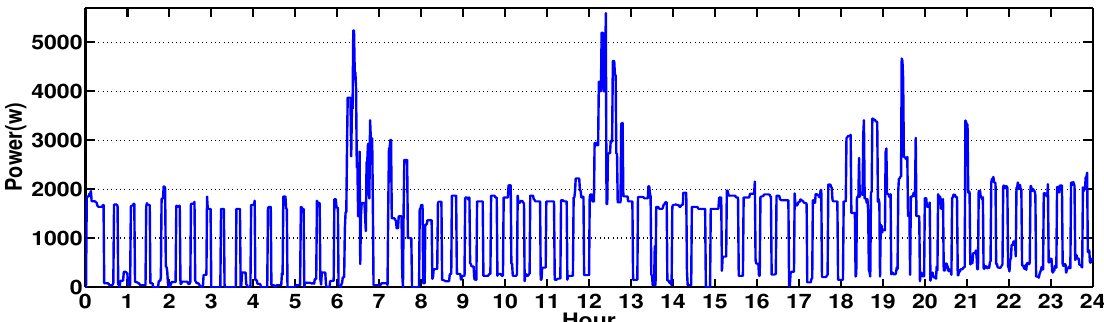
Figure 8. Building power consumption without using any smart plug and energy management